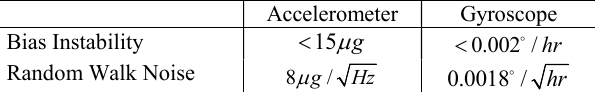
Table 1 . Specification of iNAV-RQH IMU.